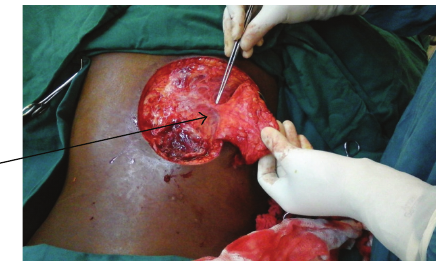
Figure 2: Perforator fasciocutaneous flap with arrow pointing to the blood vessels.